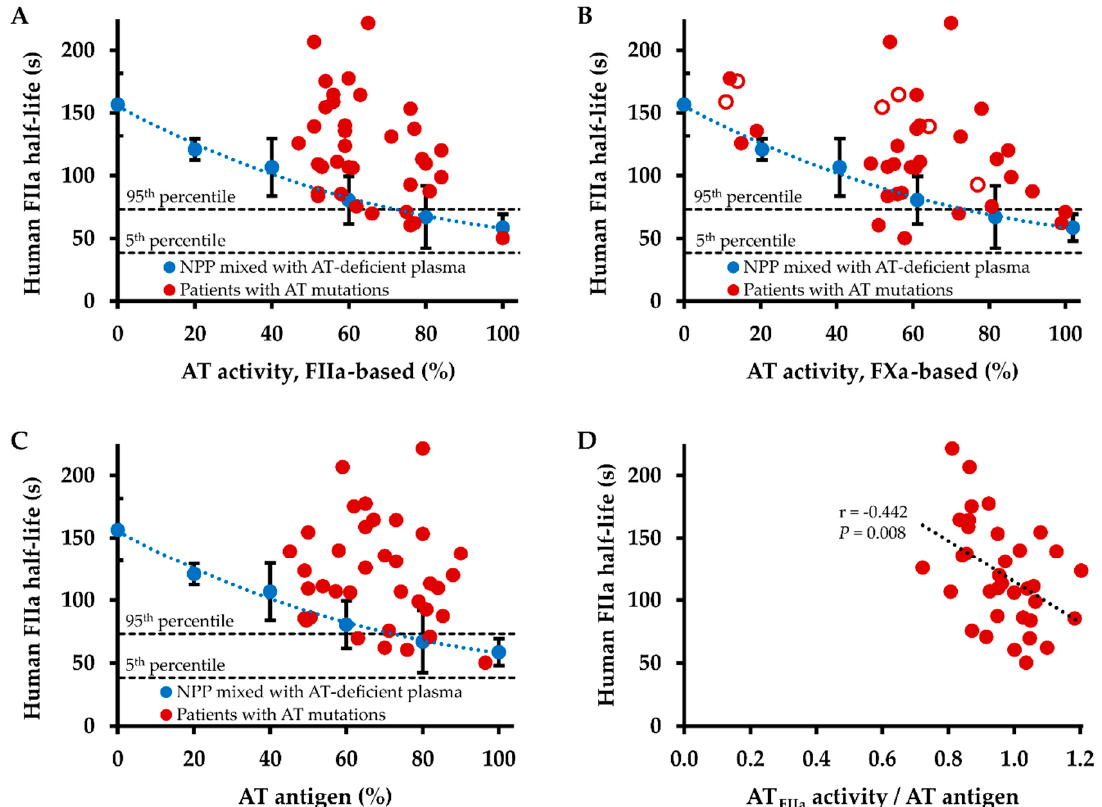
Figure 3. Dependence of inhibition kinetics of human thrombin (FIIa) on antithrombin (AT) plasma levels. ( A ) The half-life of exogenously added human thrombin (2 ng/mL final concentration) was determined in citrated plasma obtained from patients with AT mutations (red circles, n = 36)) and in normal pooled plasma (NPP) mixed with AT-deficient plasma to achieve the indicated AT levels (blue circles). Data points in blue represent means of three independent determinations on three different days, error bars represent the standard deviation. The intersected lines parallel to the x-axis indicate the 95th and 5th percentiles of half-life times measured in healthy controls ( n = 26). Functional AT levels were determined by a thrombin-based assay. ( B ) Functional AT levels were determined by an activated factor X (FXa)-based assay. Data points filled white indicate plasma from patients under therapy with FXa inhibitors. ( C ) AT antigen levels were determined by an immunoassay. ( D ) Correlation of the ratio of AT activity determined by a FIIa-based assay and AT antigen concentration with the plasma half-life of exogenously added human thrombin. r indicates the Pearson correlation coefficient.